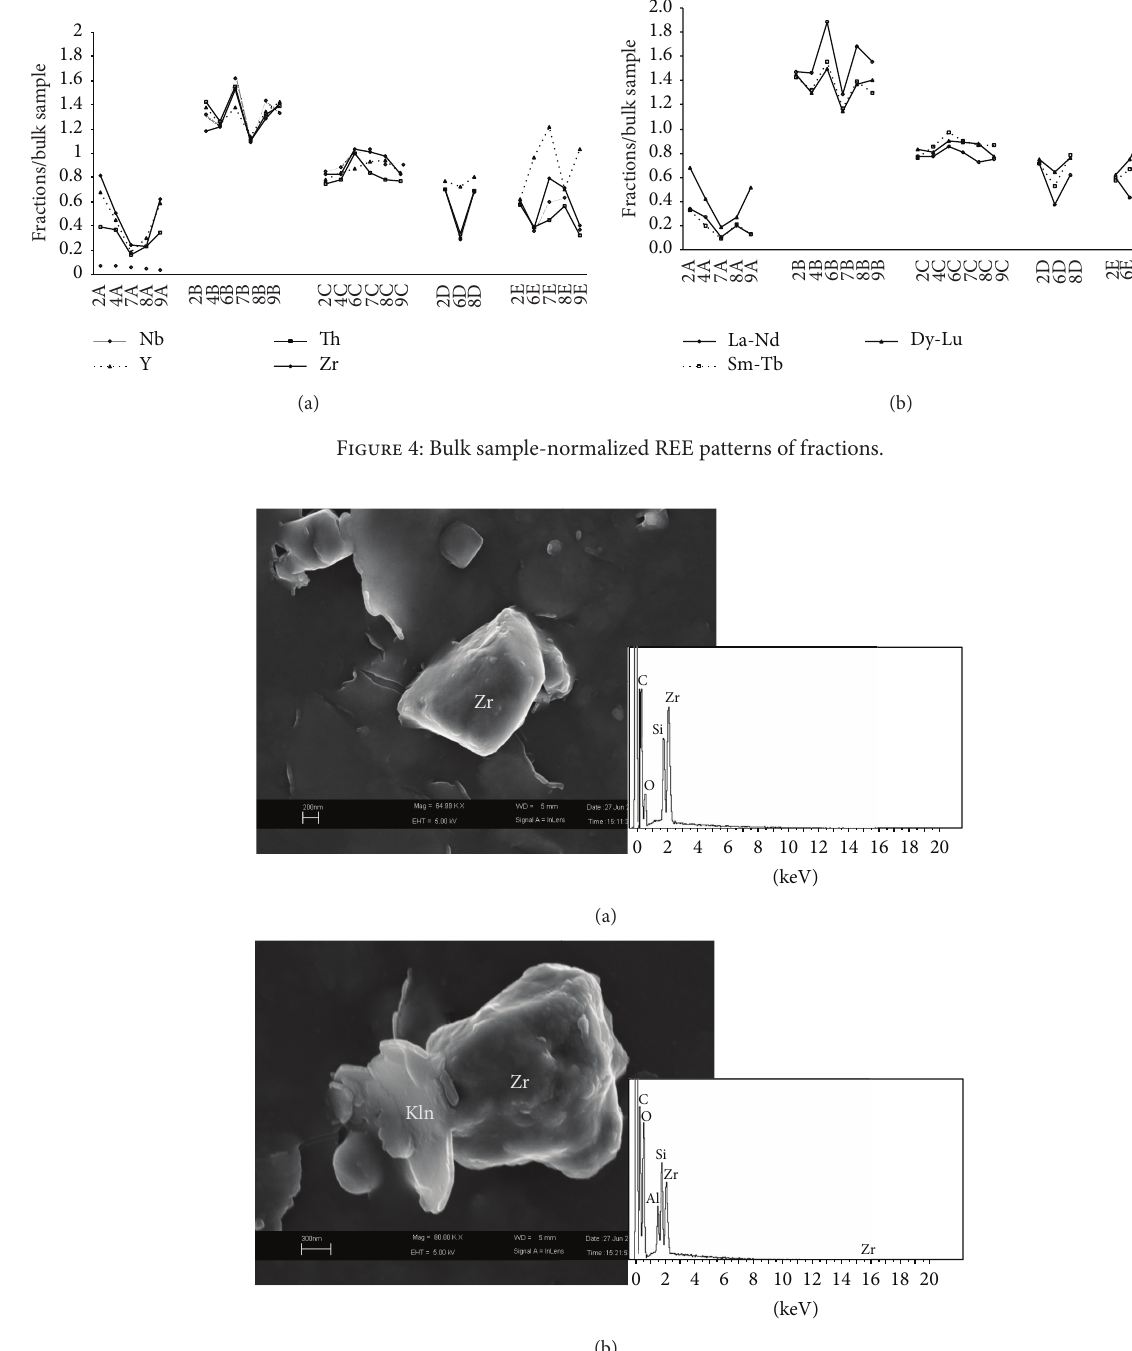
Figure 5: SEM images of (a) single particle of zircon (Zr) and (b) zircon (Zr) and kaolinite (kao)